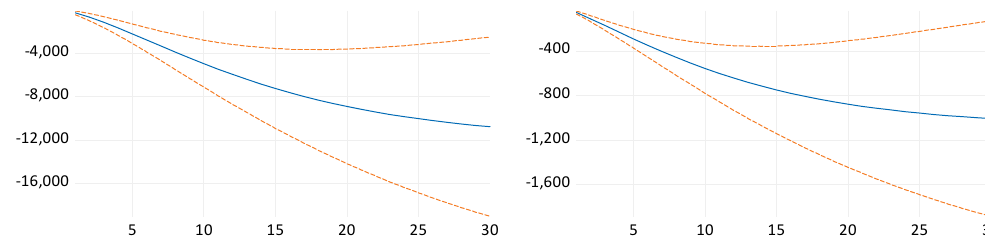
Figure 7. Responses of volatility in equity indices to structural innovations in VIX. Estimates and two standard deviation confidence band are in solid and dotted lines. SVAR lag order is one. 13 August 2015 − 17 May 2016.